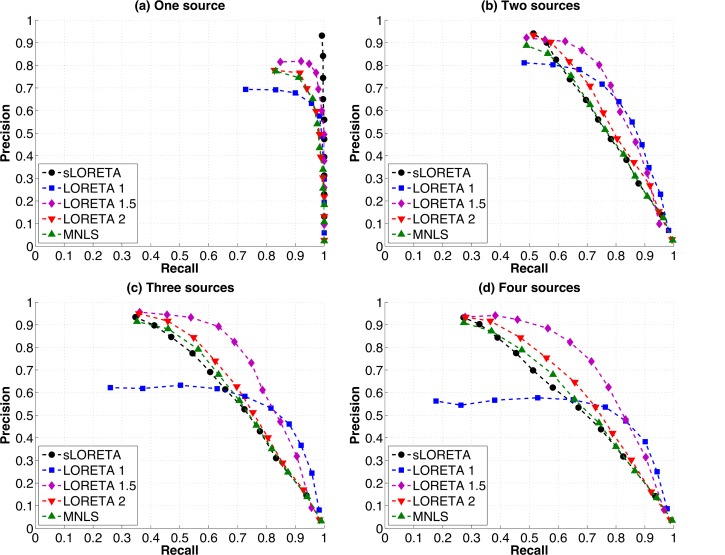
Precision vs. Recall of each of the source localization algorithms (MNLS, sLORETA, LORETA 1, 1.5 and 2) for (a) one, (b) two, (c) three and (d) four simulated sources.Each point indicates the Precision and Recall for a different strength threshold. For one source (a) sLORETA simultaneously has Precision and Recall values of close to 1, indicating perfect performance, while other algorithms have lower peak Precision. For two sources (b) all algorithms reach peak Precision only when Recall has been reduced to about 0.5, and peak Recall is reached only when Precision has dropped below 0.3. For three sources (c) LORETA 1.5 has higher Recall for many Precision values than other algorithms, LORETA 1 has lower peak Precision, while all other algorithms follow a similar pattern, with high Precision that drops off steeply with increasing Recall. For four sources (d) while peak Precision is still high for most algorithms, Recall drops slightly.